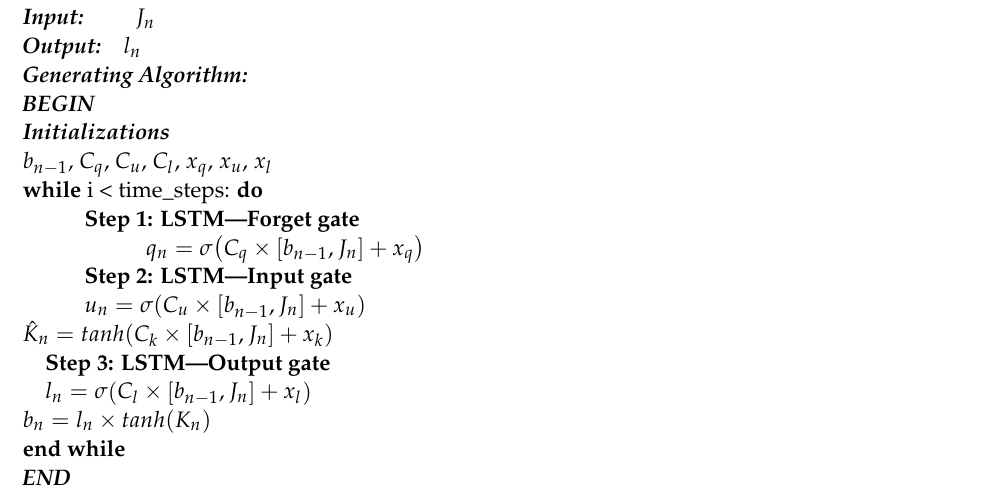
Algorithm 1: Computation algorithm of LSTM Cell